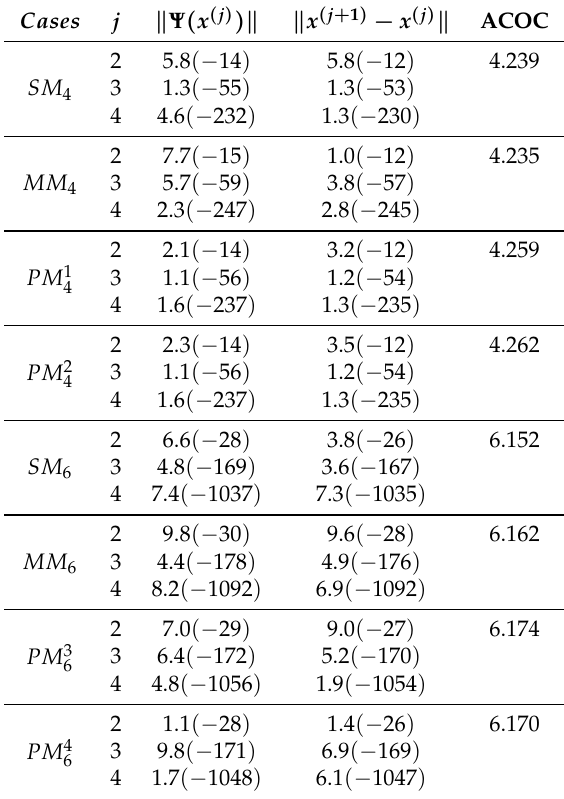
Table 3. Comparative study of different methods for Example